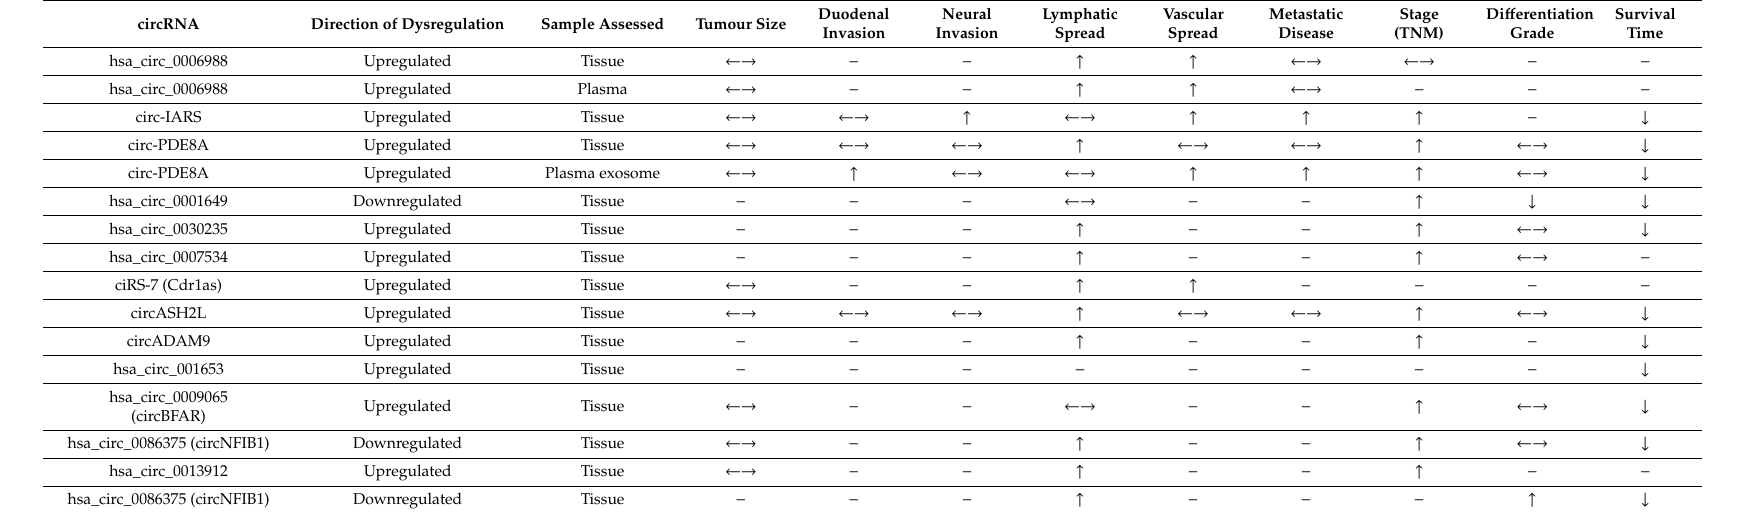
Table 5. Summary table of clinical characteristics seen with di ff erential circRNA expression in PDAC. “ ↑ ” indicates an increase; “ ↓ ” indicates a decrease; “ ←→ ” indicates no significant di ff erence demonstrated; and “ − “ indicates this measure was not